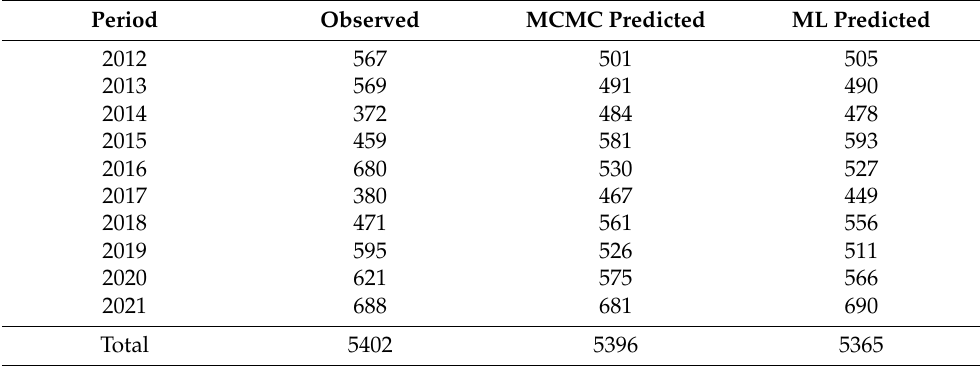
Table 5. Annual number of pipe